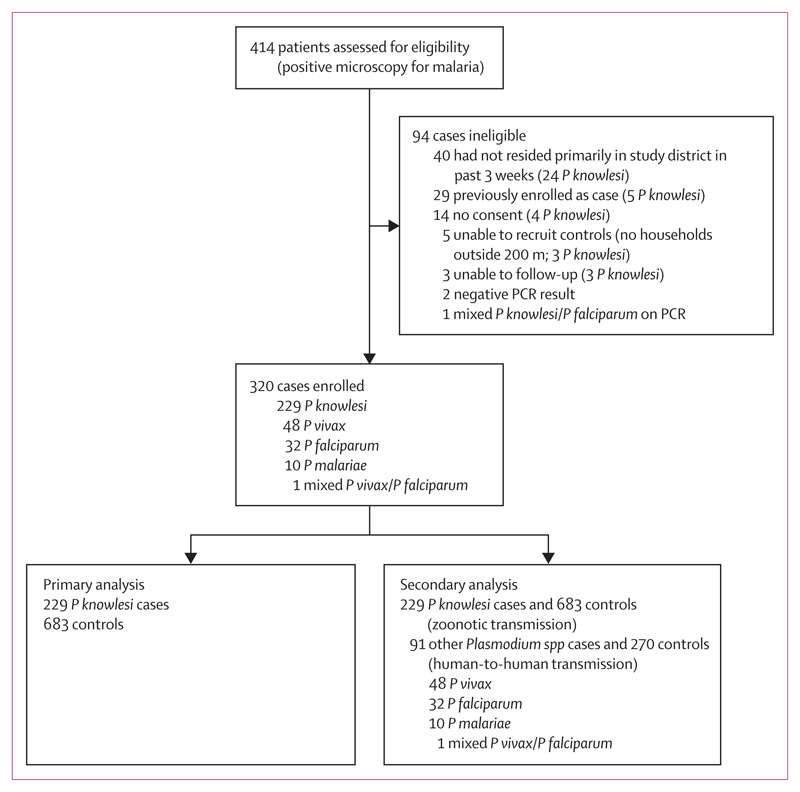
Study designP knowlesi=Plasmodium knowlesi. P vivax=Plasmodium vivax. P falciparum=Plasmodium falciparum.P malariae=Plasmodium malariae.